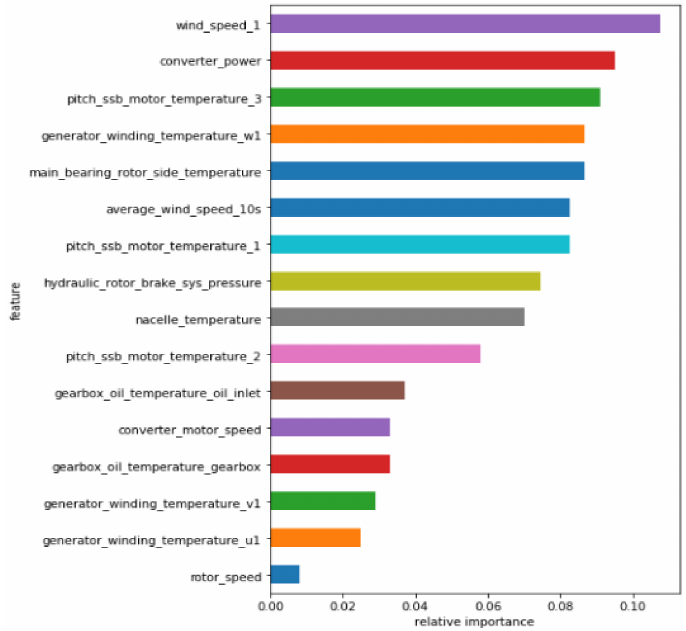
Figure 5. Random forest feature importance ranking